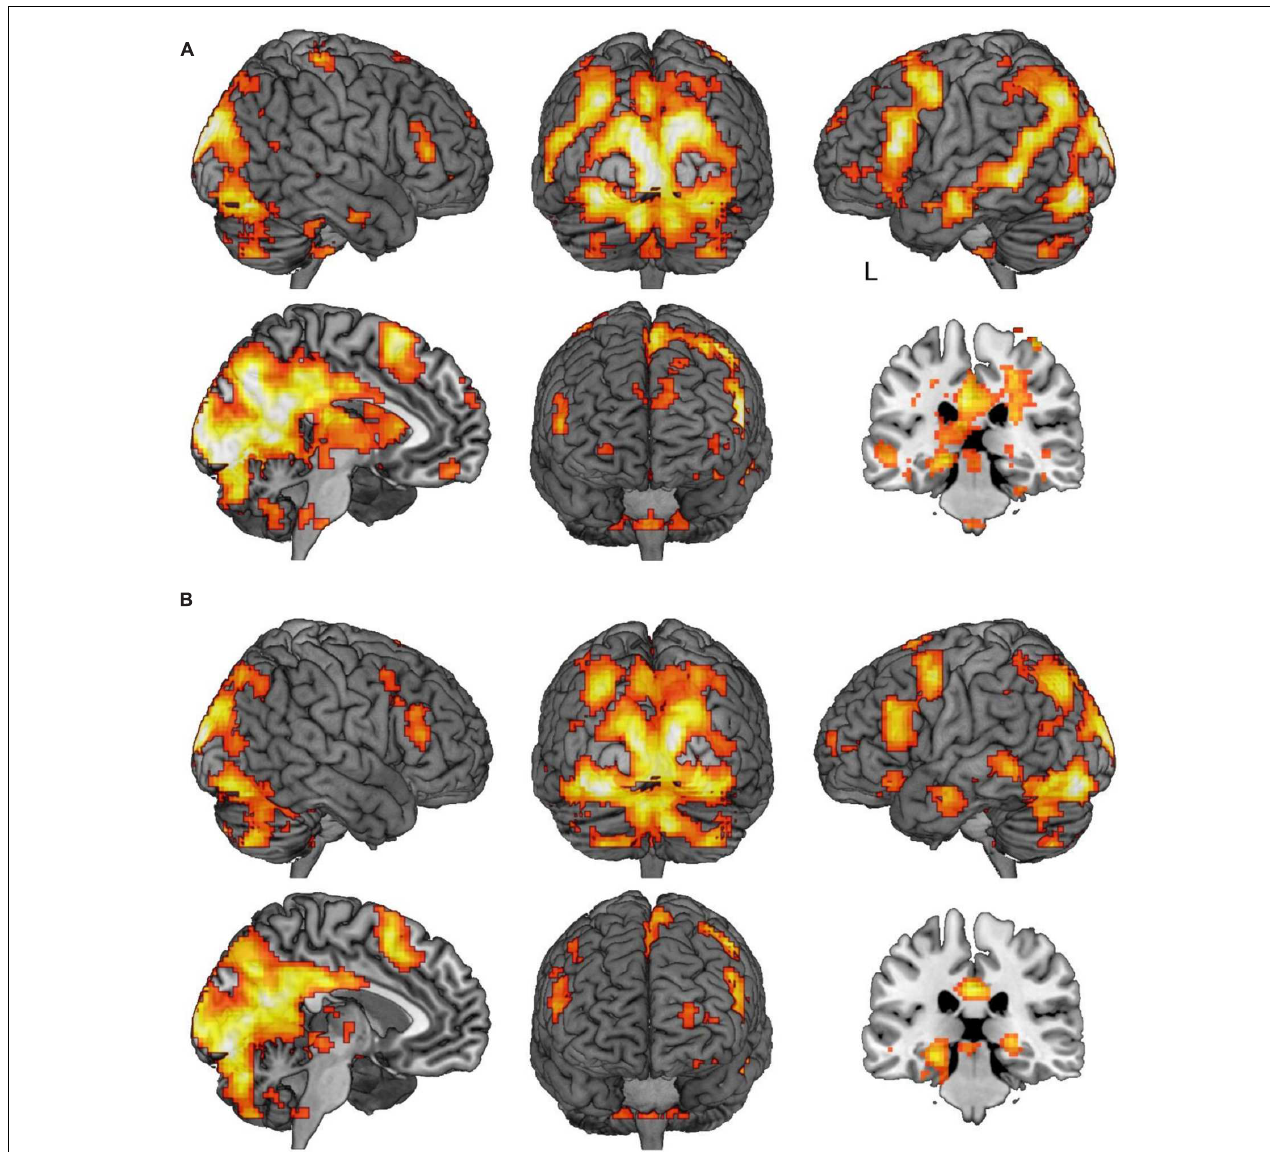
FIGURE 3 | Regions of activation in the think/memory substitution vs. no-think1 and 2 contrasts. (A) Regions demonstrating significant activation in the think vs. no-think1 contrast. (B) Regions demonstrating significant activation in the memory substitution vs. no-think2 contrast. Images in both panels are thresholded at p < 0.001 with clusters comprising a minimum of five contiguous voxels. In both panels, the sagittal slice is marked with an L indicating the side of the left hemisphere and is rendered where x = − 5. The coronal slice is rendered at y = −